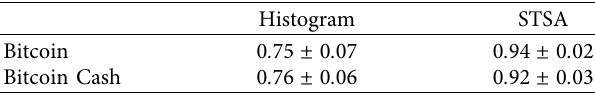
Table 4: Shannon